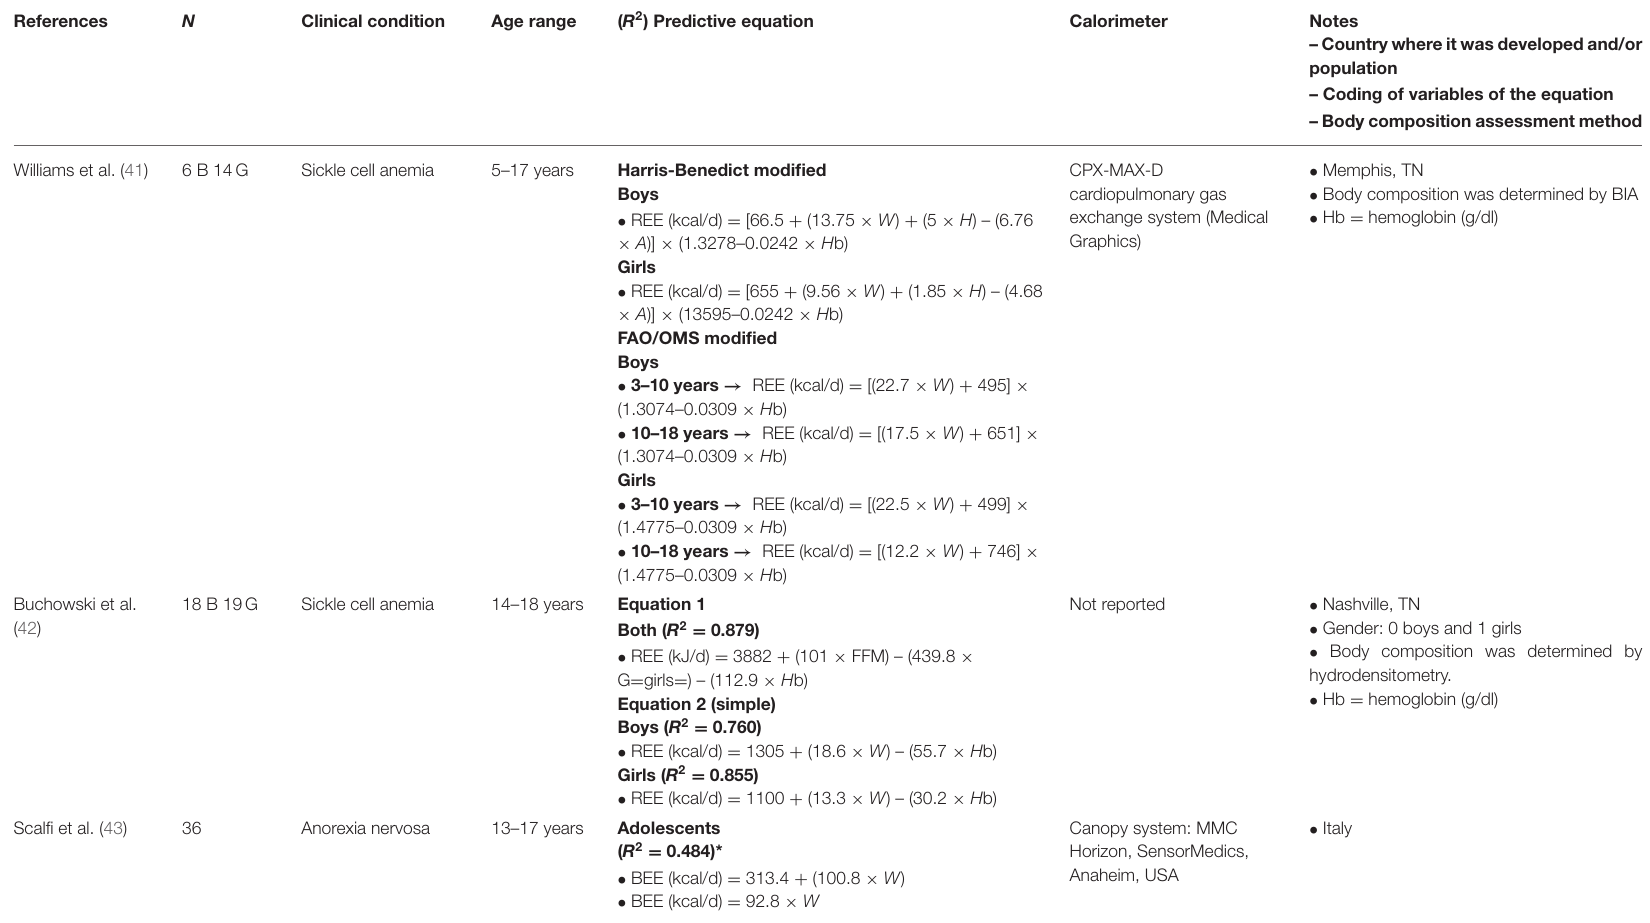
TABLE 4 | Equations for the prediction of energy expenditure in the pediatric population with specific clinical